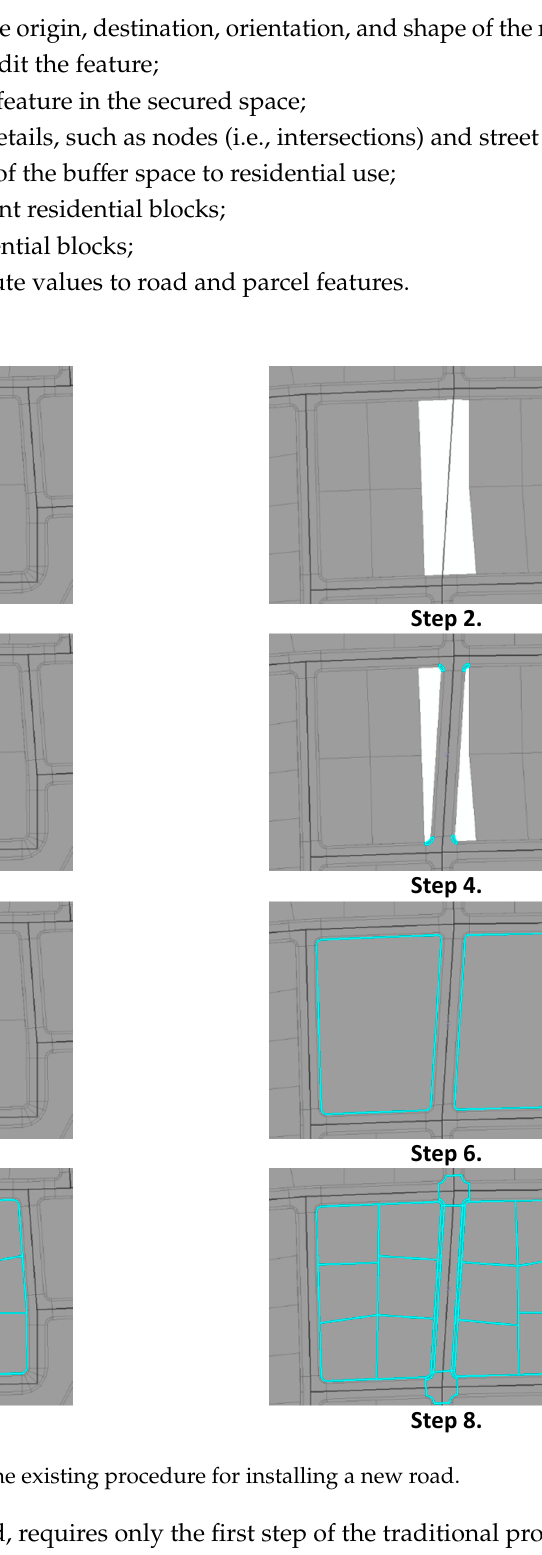
Figure 8. An alternative procedure for installing a new road using CityEngine. The benefits of using procedural modeling do not stop here. As Figure 9 illustrates, CityEngine creates real-time 3-dimensional models using the default values embedded in a rule file or feature